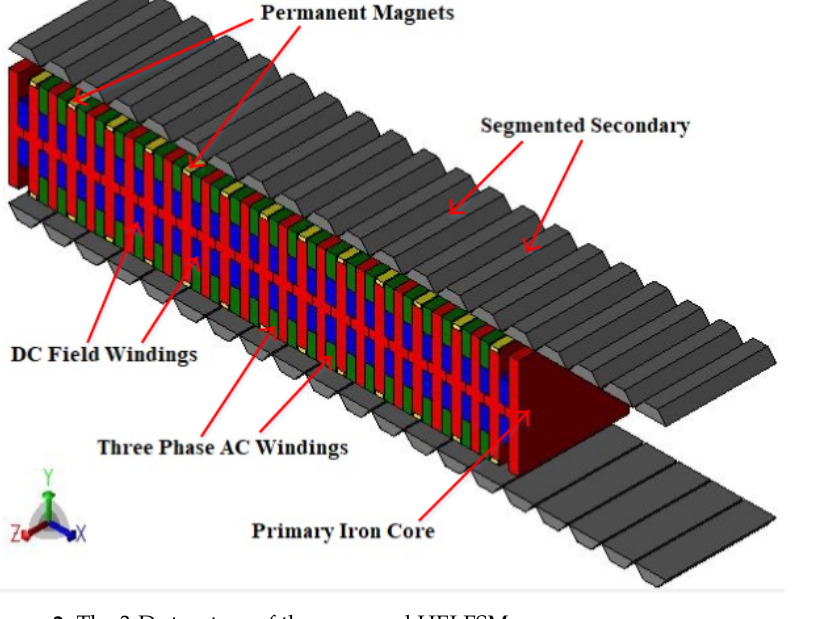
Figure 2. The 3-D structure of the proposed HELFSM.